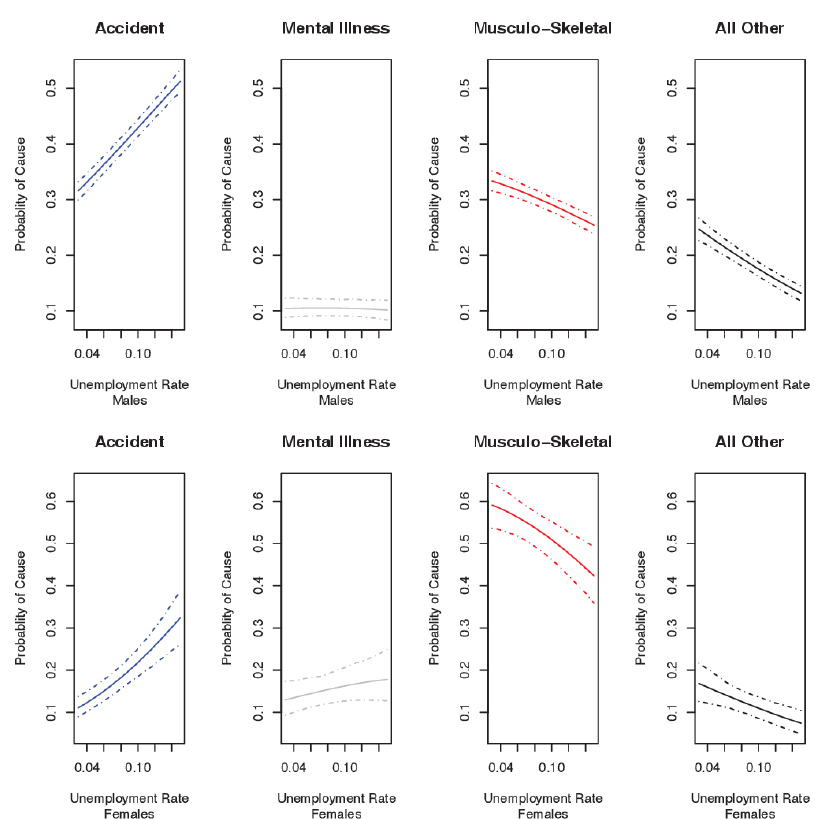
Figure 4. Insured population multinomial logit model: probability of claim cause at each level of unemployment rate